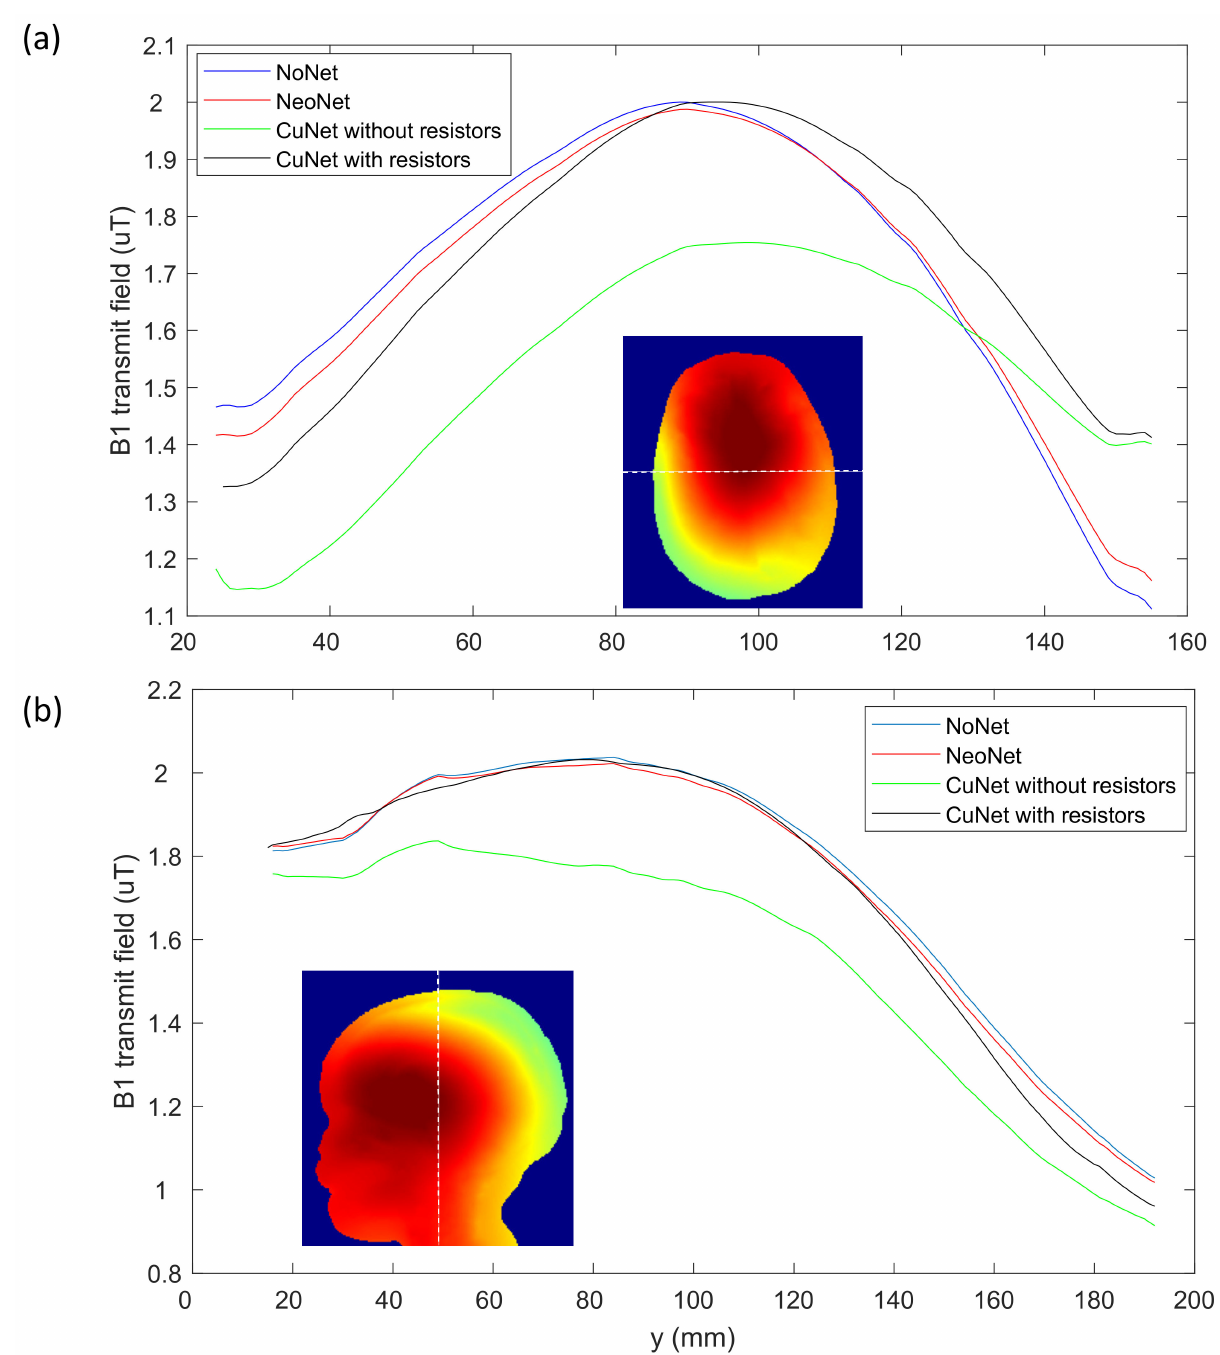
Figure 10. Comparison of the B 1 transmit field among four cases with dashed lines of the position of the profile. ( a ) Axial profile and ( b ) longitudinal profile in the central